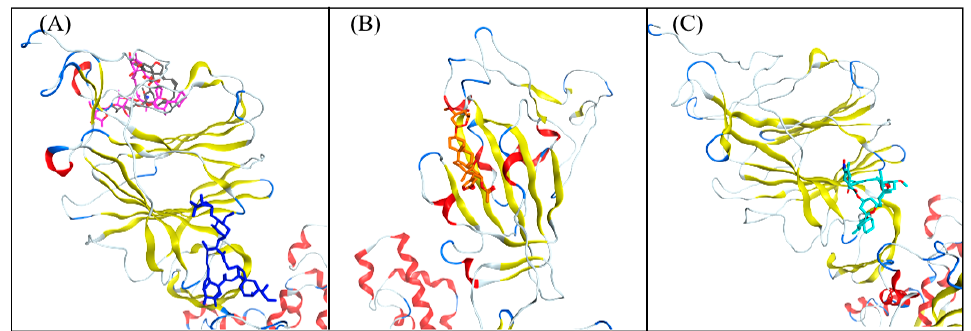
Figure 2. Binding poses of ( A ) ivermectin (dark blue), moxidectin (dark gray), doramectin (purple) on S1-NTD open conformation; ( B ) oleandrin (orange) on S1-RBD closed conformation; ( C ) selamectin (cyan) on S1-NTD closed